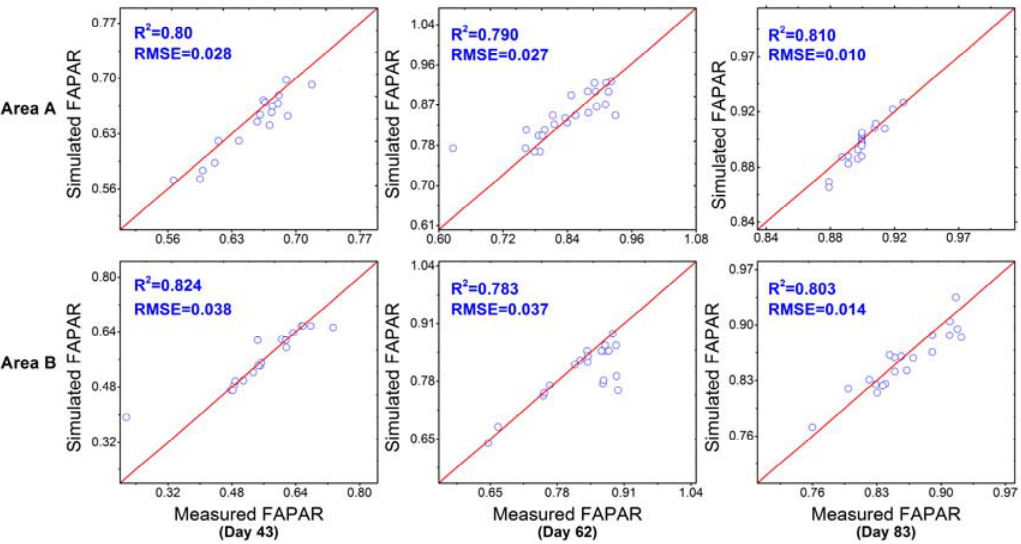
Figure 5. Validation of simulated FAPAR against measured FAPAR at different times in different regions. Day 43 represents the jointing-booting stage of rice, Day 62 represents heading-the flowering stage of rice and Day 83 represents the ending of flowering stage of rice. Note that all days means day after transplanting.